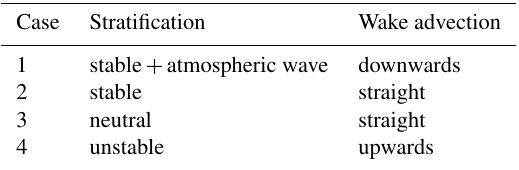
Table 1. Wake categorization according to stratification (the strat- ification is defined by the Obukhov length: stable 1 /L mo > 0 .